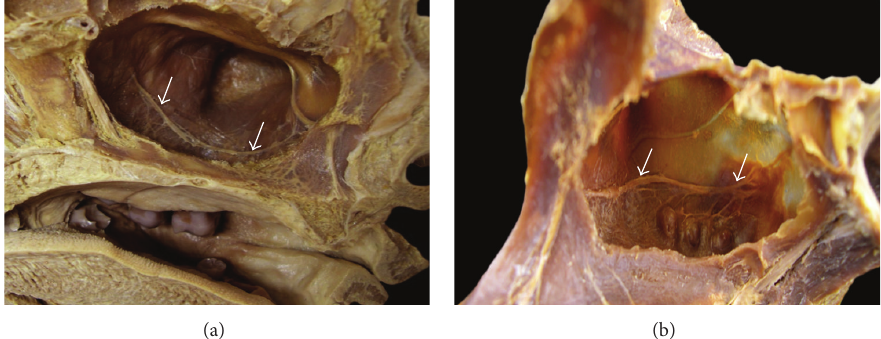
Figure 6: (a, b) Route of the posterior superior alveolar neurovascular bundles in dissected anatomical specimens (white